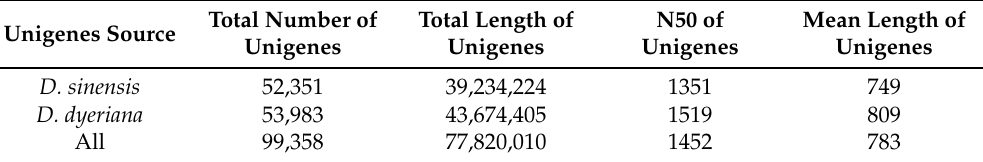
Table 2. Summary of the unigenes from two Dipteronia